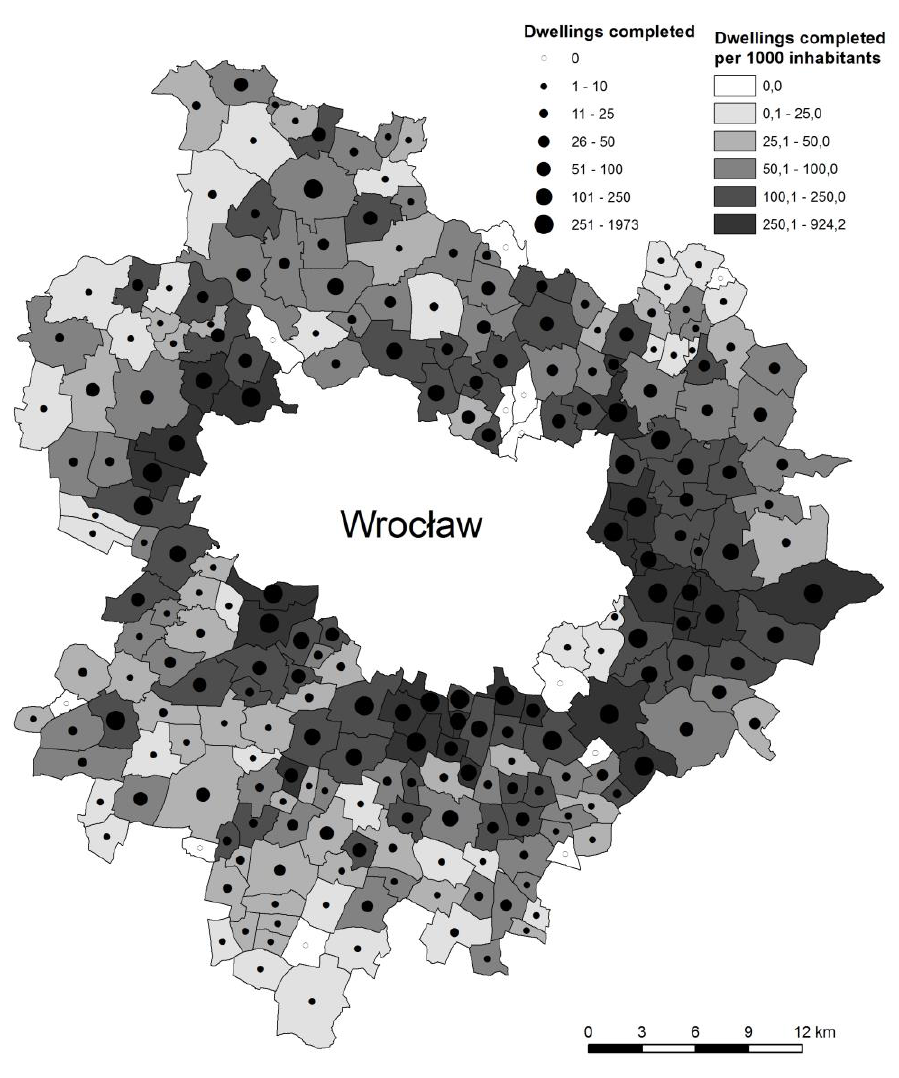
Fig. 7. Construction traffic in statistical units in suburban zone of Wrocław